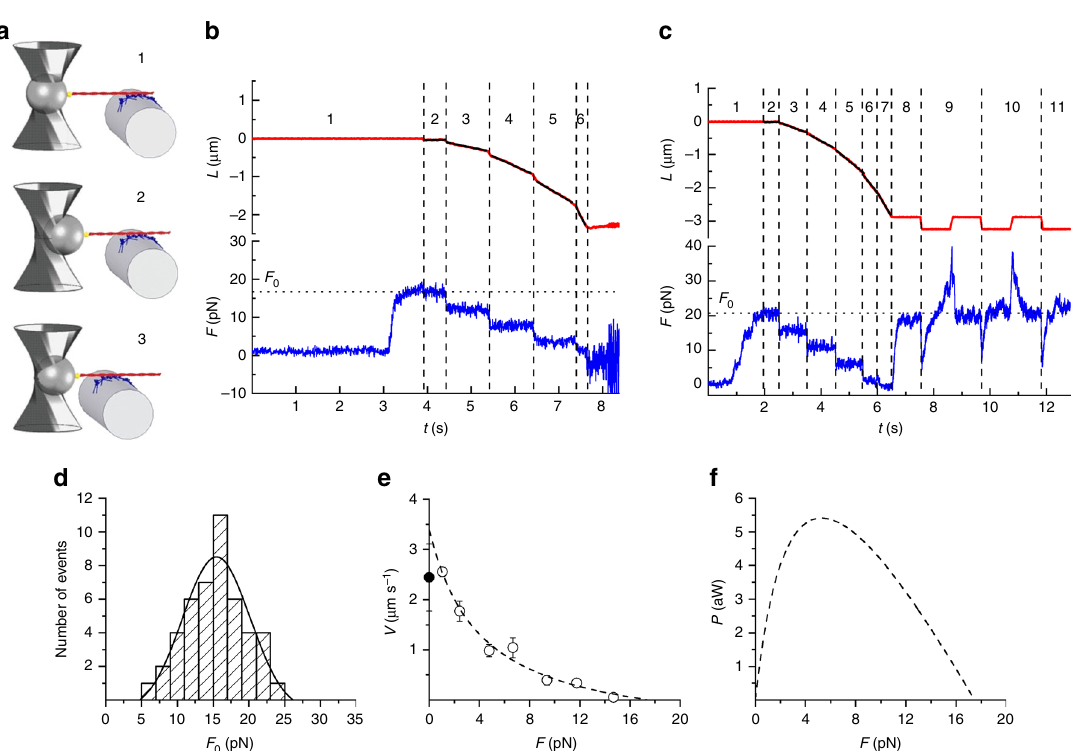
Fig. 2 Mechanical output of the myosin-II nanomachine in 2 mM ATP. a Schematic representation of three snapshots during the phases of the interaction between the actin fi lament and the motors numbered as in b . Components of the system coloured as in Fig. 1a. b Recording of the relative sliding (red trace) and force (blue trace) during the interaction. Phase 1, following the formation of the fi rst bonds between the actin fi lament and myosin motors, the force rises in position feedback to the maximum isometric value ( F 0 ~ 17 pN). Phases 2 – 6, shortening response to a staircase of stepwise reductions in force (4 pN) separated by 1 s imposed in force feedback. c Another experiment in which in phase 1 in position feedback isometric force rises to F 0 (~21 pN) with some force fl uctuations and in frames 2 – 7 the staircase in force feedback is made by 5-pN steps separated by 1 s (3 – 5) and 0.5 s (6, 7). In phase 8, after a total active sliding of 2.7 µ m, the control is switched back to position feedback, and the force redevelops up to the original F 0 . Phases 9 – 11, force response to a series of rapid lengthenings and shortenings of ~500 nm superimposed on F 0. In both b , c , black lines are superimposed on the length trace to better appreciate the slope. d Frequency distribution of F 0 . Data are plotted in classes of 2 pN and fi tted with a Gaussian (continuous line): centre = 15.5 ± 0.4 pN, σ = 4.7 ± 0.4 pN (mean ± SEM, n = 46). e Force – velocity ( F – V ) relation. The black fi lled symbol on the ordinate is the V f value from IVMA (see related Supplementary Fig. 4). The dashed line is Hill ’ s hyperbolic fi t to the data. f Power – force ( P – F ) relation from the fi t in